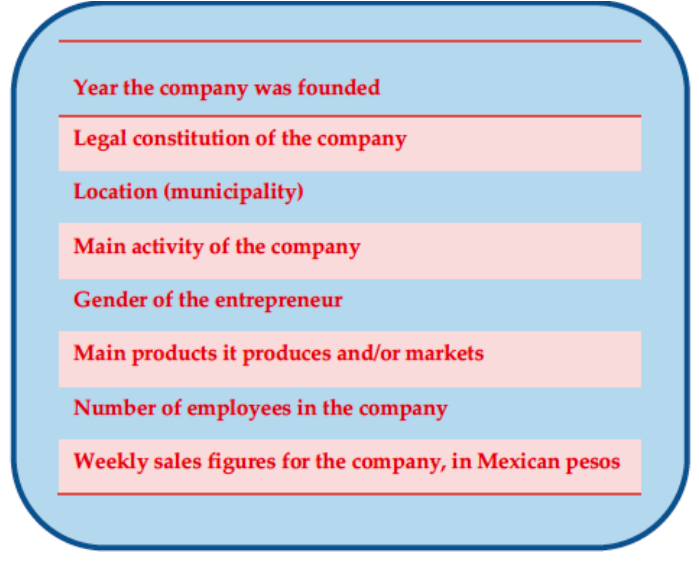
Figure 4. Selection of variables used in the study. Source: Own elaboration.